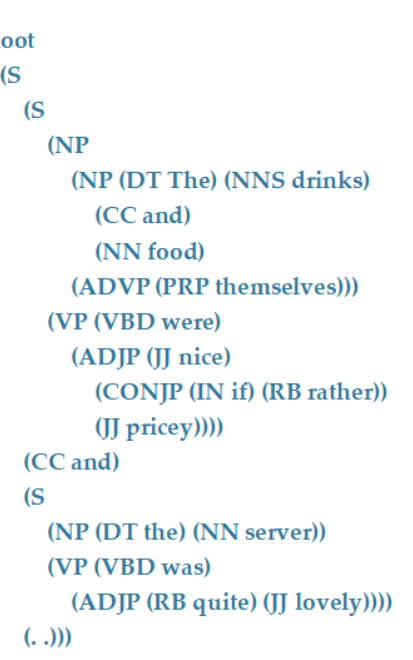
Figure 2. The syntactic tree of an example sentence.